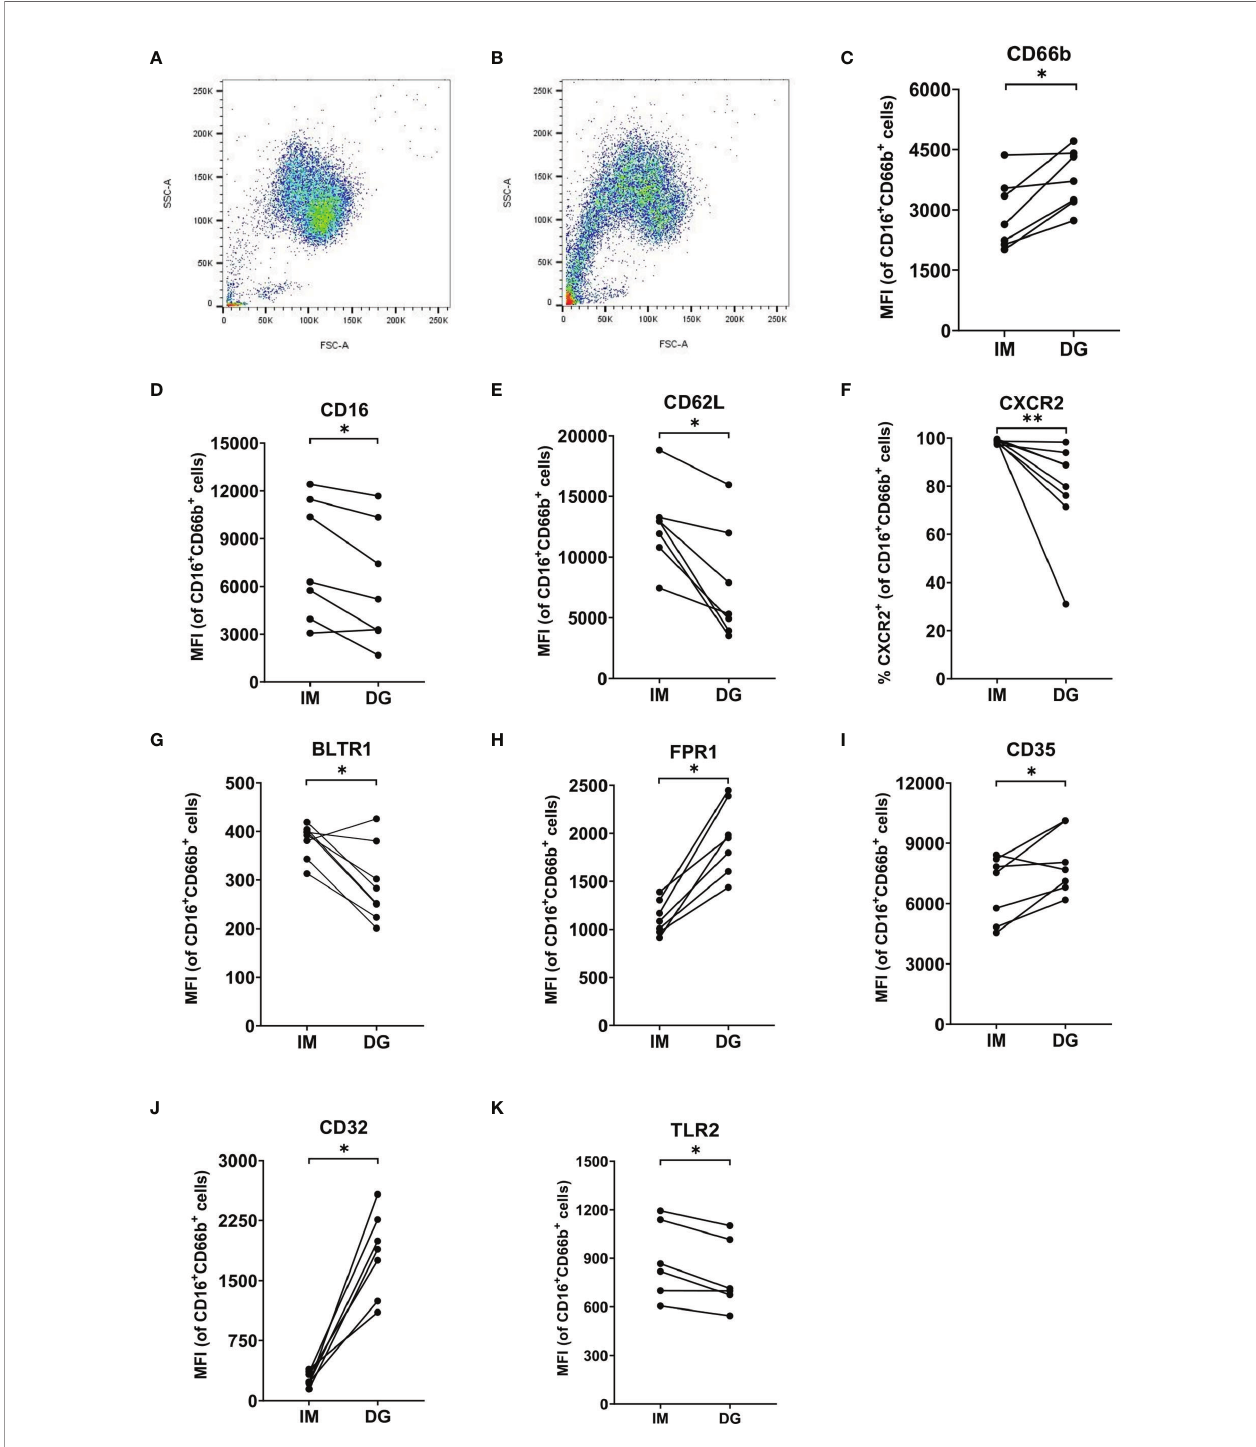
FIGURE 6 | Neutrophils puri fi ed by density-gradient centrifugation display an activated phenotype. Flow cytometry was used to evaluate the (A, B) size (FSC), granularity (SSC) and surface expression of (C) CD66b, (D) CD16, (E) CD62L, (F) CXCR2, (G) BLTR1, (H) FPR1, (I) CD35, (J) CD32 and (K) TLR2 on neutrophils (gated as CD16 + CD66b + cells) isolated by immunomagnetic (IM) or density-gradient puri fi cation (DG) from peripheral blood of healthy donors. Results are represented as percentage of neutrophils positive for the marker or median fl uorescence intensity (MFI). Results from each individual donor (n = 6-8) are connected by lines and were statistically analyzed by Wilcoxon matched-pairs signed rank test (*p < 0.05; **p < 0.01 for statistical differences between neutrophils puri fi ed with immunomagnetic or density-gradient